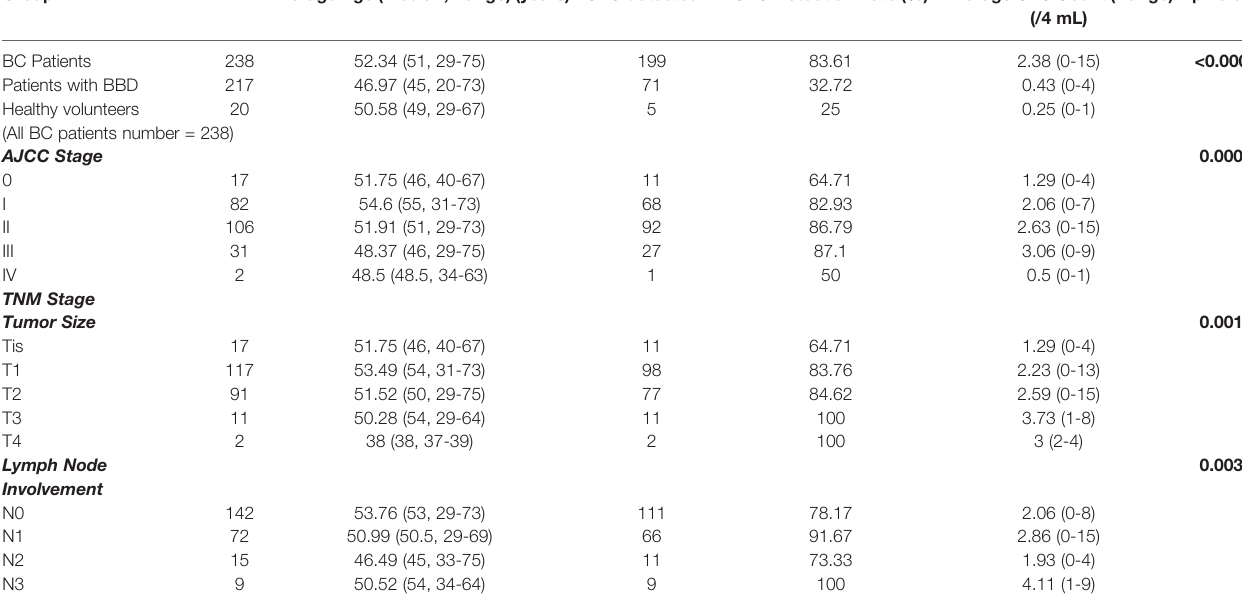
CTC, circulating tumor cell; n, number of patients; BC, breast cancer; BBD, benign breast diseases; AJCC, American Joint Committee on Cancer; TNM, tumor-node-metastasis; Tis, tumor in situ. *The p value of comparisons is based on the CTC enumeration of each group. Bold values mean statistical signi fi